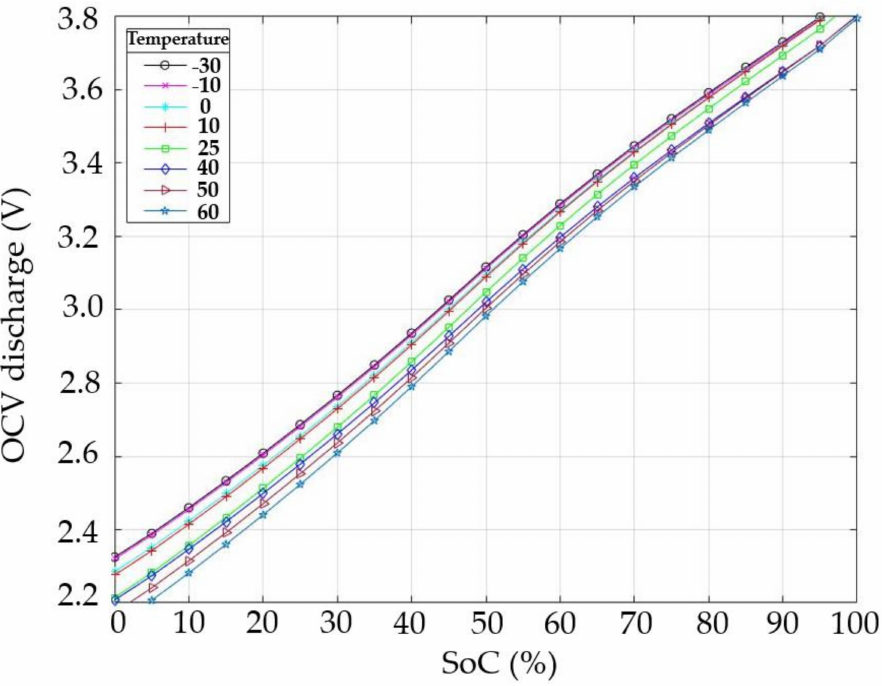
Figure 9. The OCV–SoC curve for discharging of the LiC cell at 10 A current.